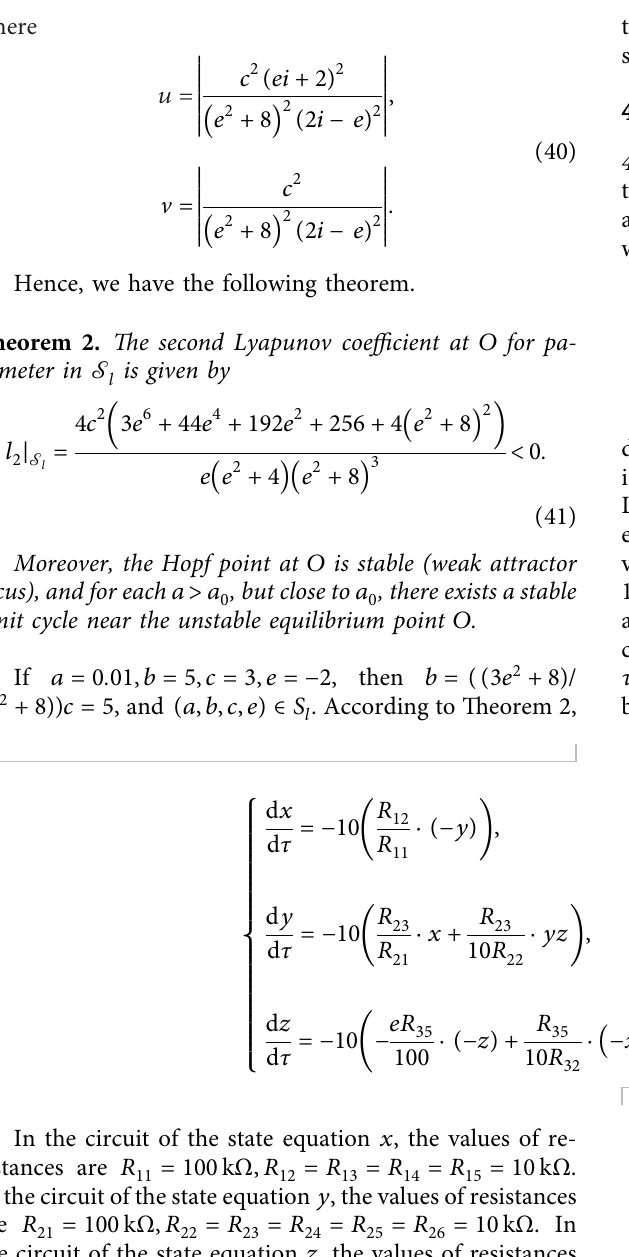
From Figure 8(e), under the parameters a � − 4 . 5 and b � − 1, the symmetric limit cycle can be observed. From Figure 8(f), under the parameters a � − 0 . 8 and b � − 1, the symmetric pair of limit cycles can